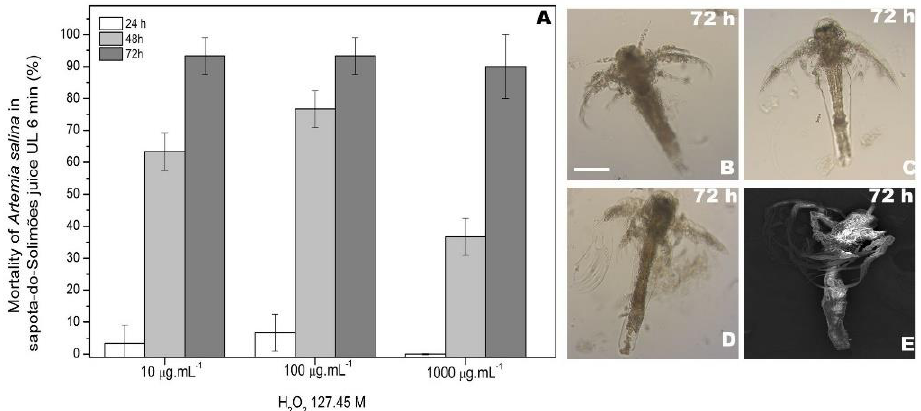
exposure. In contrast, after 72 h the mortality rate was also 90%. The components of the food matrix can enhance the protective effect. For example, ultrasound-processed coconut water presented a remarkable protective effect against H 2 O 2 with a mortality rate of 60% after 72 h of exposure [22]. After 72 h of the protective effect assay (Figure 7B–D), the deterioration of the A. salina body was observed with a difference in the body density of the highest concentrations (100–1000 µ g · mL − 1 ). Figure 7E shows that A. salina (1000 µ g · mL − 1 ) after 72 h presented a loss in body integrity. The morphological development of A. salina decreased when the concentration of tributyltin chloride (antifouling substance) increased. The abnormalities are head width, abdominal width, tail width, and swimming setae, resulting in an imbalanced and irregular swimming pattern [47].